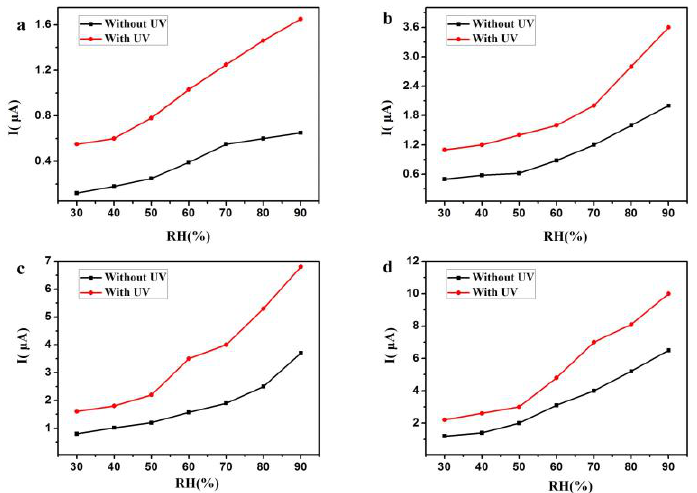
Figure 9. The humidity sensitivity from 30% RH to 90% RH at applied voltages from 1 V ( a ), 2 V ( b ), 3 V ( c ) and 4 V ( d ), with and without UV irradiation.